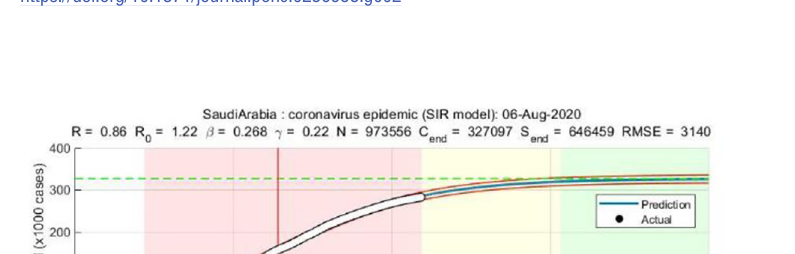
Fig 2. SIR model based on post- lockdown data (until July 1, 2020).